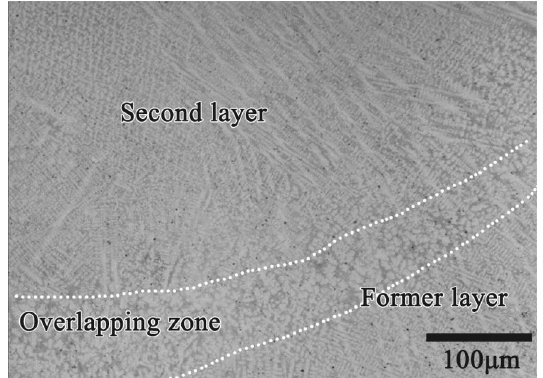
Figure 5. Microstructure at overlapping zone of the Co-based alloy cladding